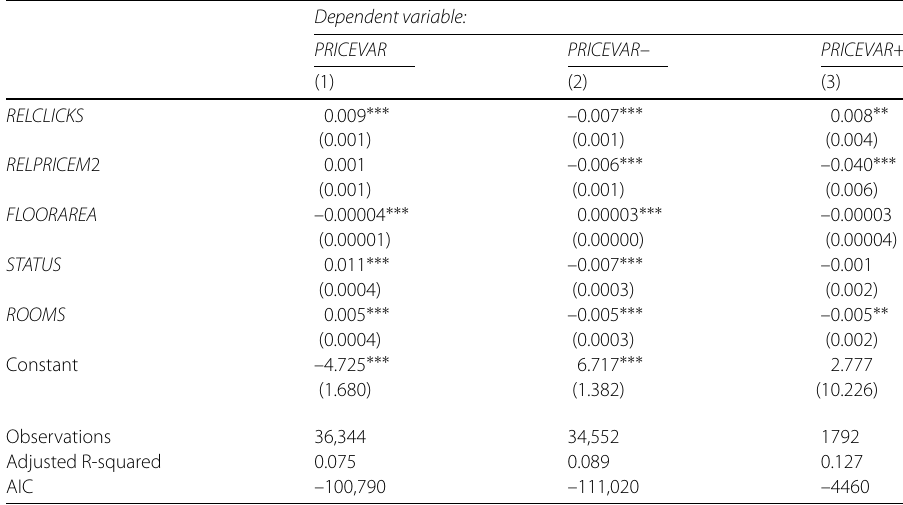
Table 2 Effect of online interest on the magnitude of price changes Dependentvariable: PRICEVAR PRICEVAR